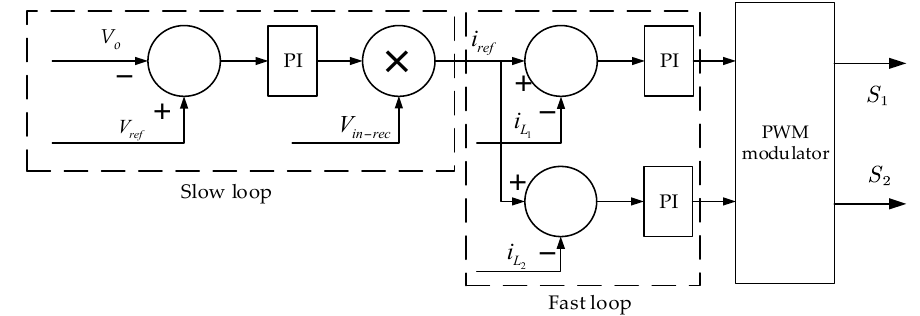
Figure 1. Average current control block of the system.